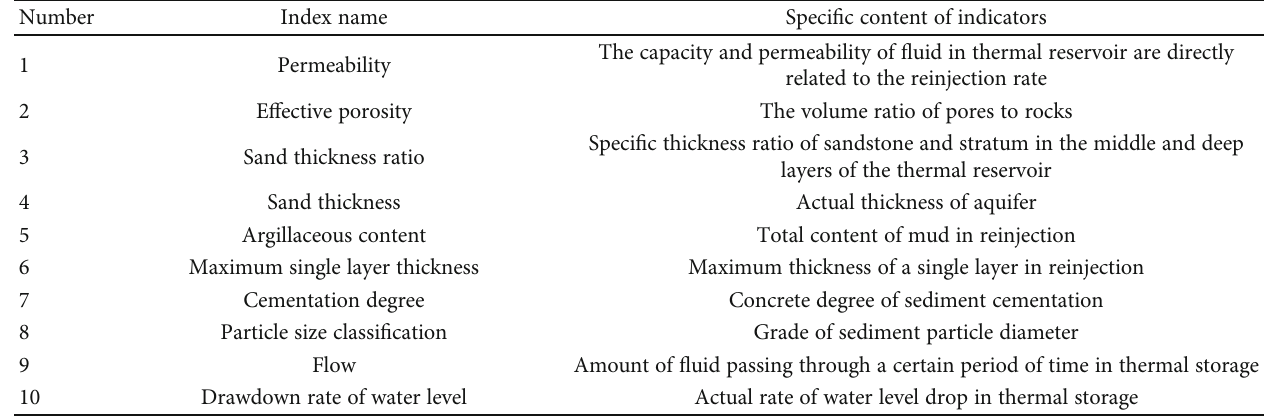
Table 3: Index in fl uencing the e ff ect of reinjection of heat storage tail water in sandstone.